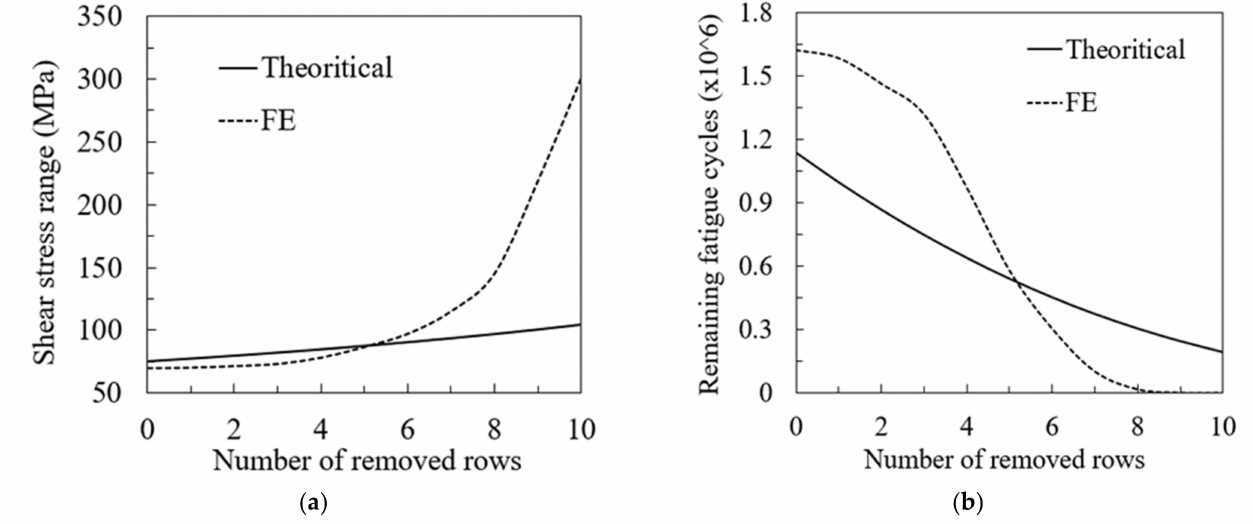
Figure 12. Comparison between the theoretical and FE results. ( a ) The shear stress range. ( b ) The remaining fatigue